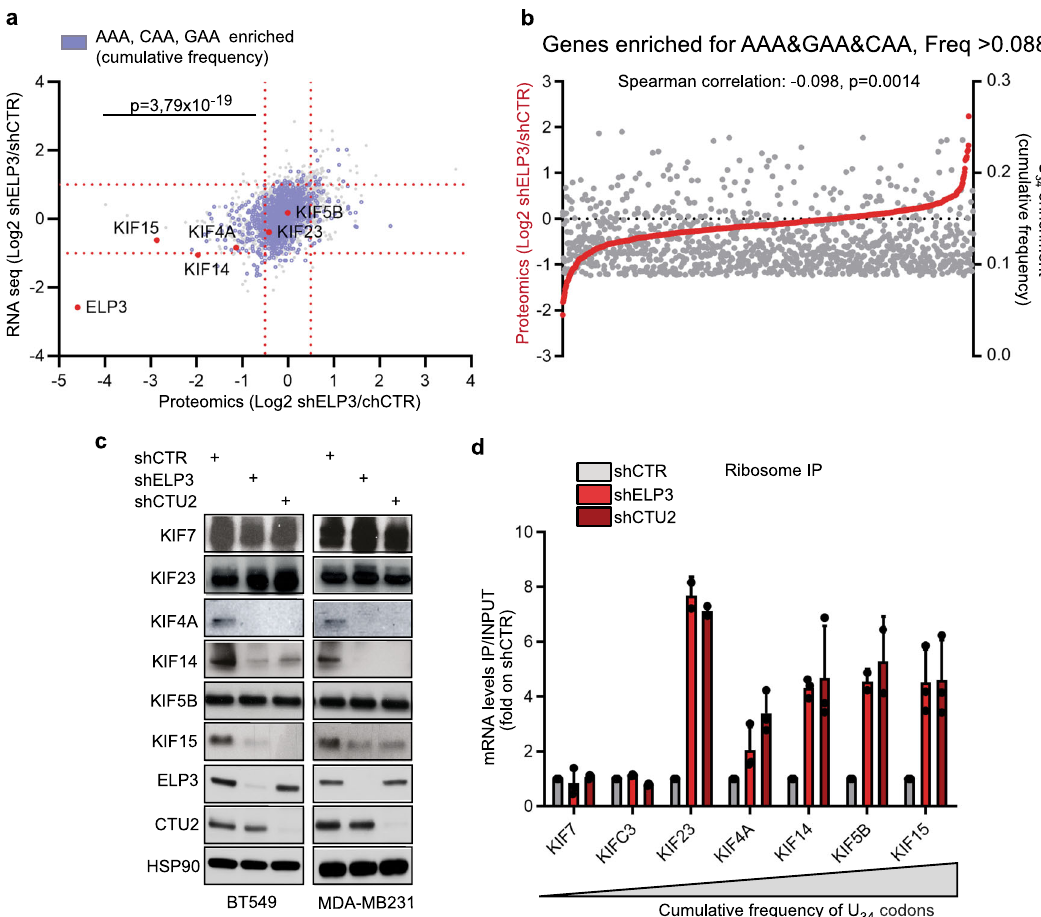
Fig. 2 mRNA codon content poorly predicts protein expression fate upon loss of U 34 -enzymes. a Dot plot of RNA-seq and proteomics of BT549 cells depleted or not of ELP3 ( n = 3 independent experiments); genes enriched in U 34 -codons are shown in blue. U 34 -codons enrichment in downregulated proteins was calculated by χ 2 test (two-sided). b , Frequency of U 34 -codons and protein expression in BT549 cells depleted of ELP3 was plotted, correlation was calculated by Spearman test (two-sided). c Levels of indicated proteins were determined in cells depleted of ELP3 or CTU2 by western blot ( n = 4 replicates). d qRT-PCR after ribosome immunoprecipitation in MDA-MDMB231 cells. n = 2 independent experiments, data are mean +